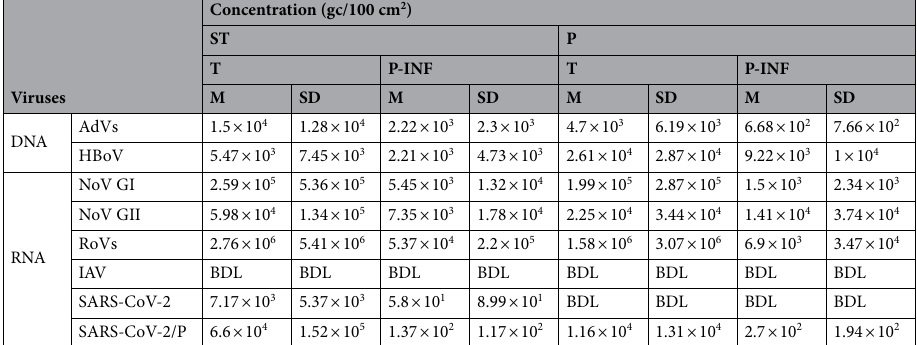
with the mean value of 9.84 × 10 7 gc/L (range 3.6 × 10 3 –8.45 × 10 8 ) and RoVs with the mean value of 1.14 × 10 7